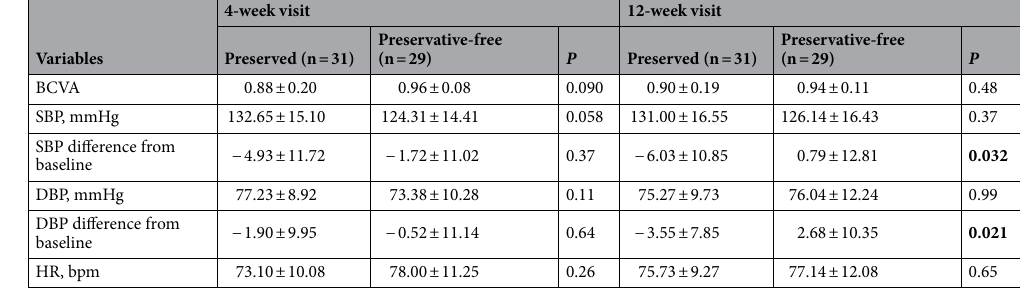
Table 4. Safety assessment at 4- and 12-week visits using per-protocol set. BCVA best-corrected visual acuity, SBP systolic blood pressure, DBP diastolic blood pressure, HR heart rate. Comparative analyses were performed using ANCOVA after adjusting age, gender, and baseline data, except for BCVA. For BCVA, Wilcoxon rank-sum test was used. Significant values with P < 0.05 are indicated in